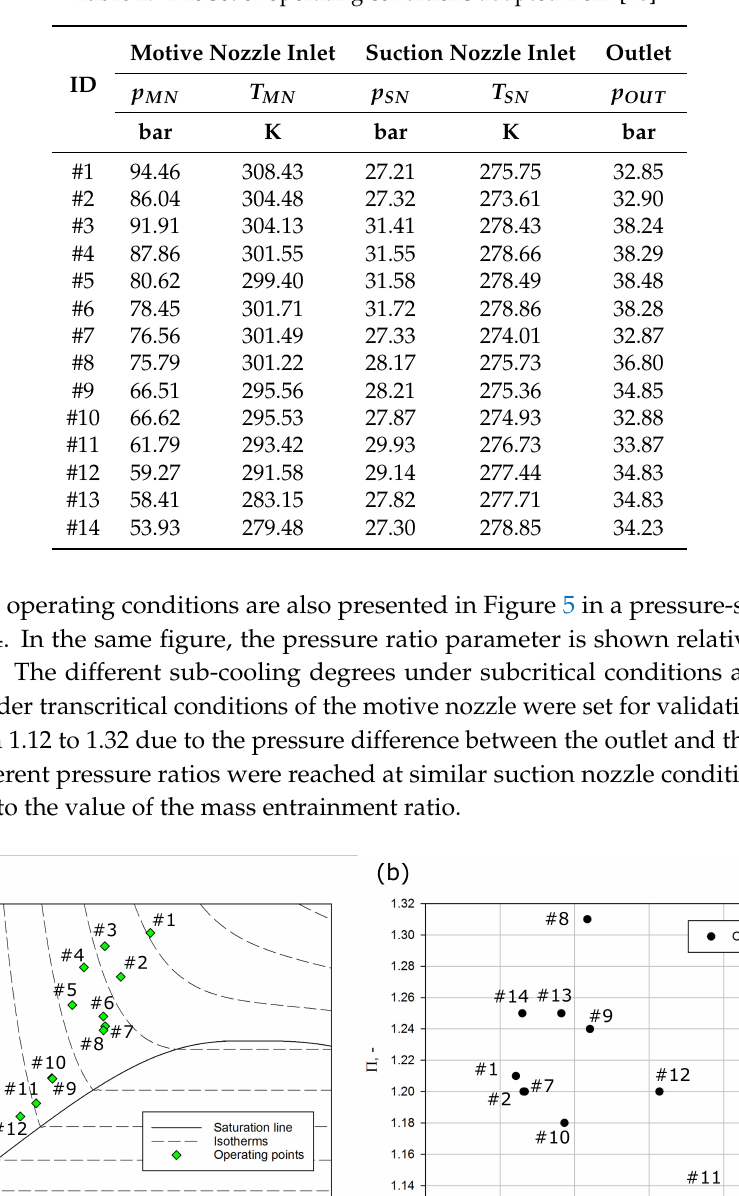
Table 2. The set of operating conditions adapted from [26].